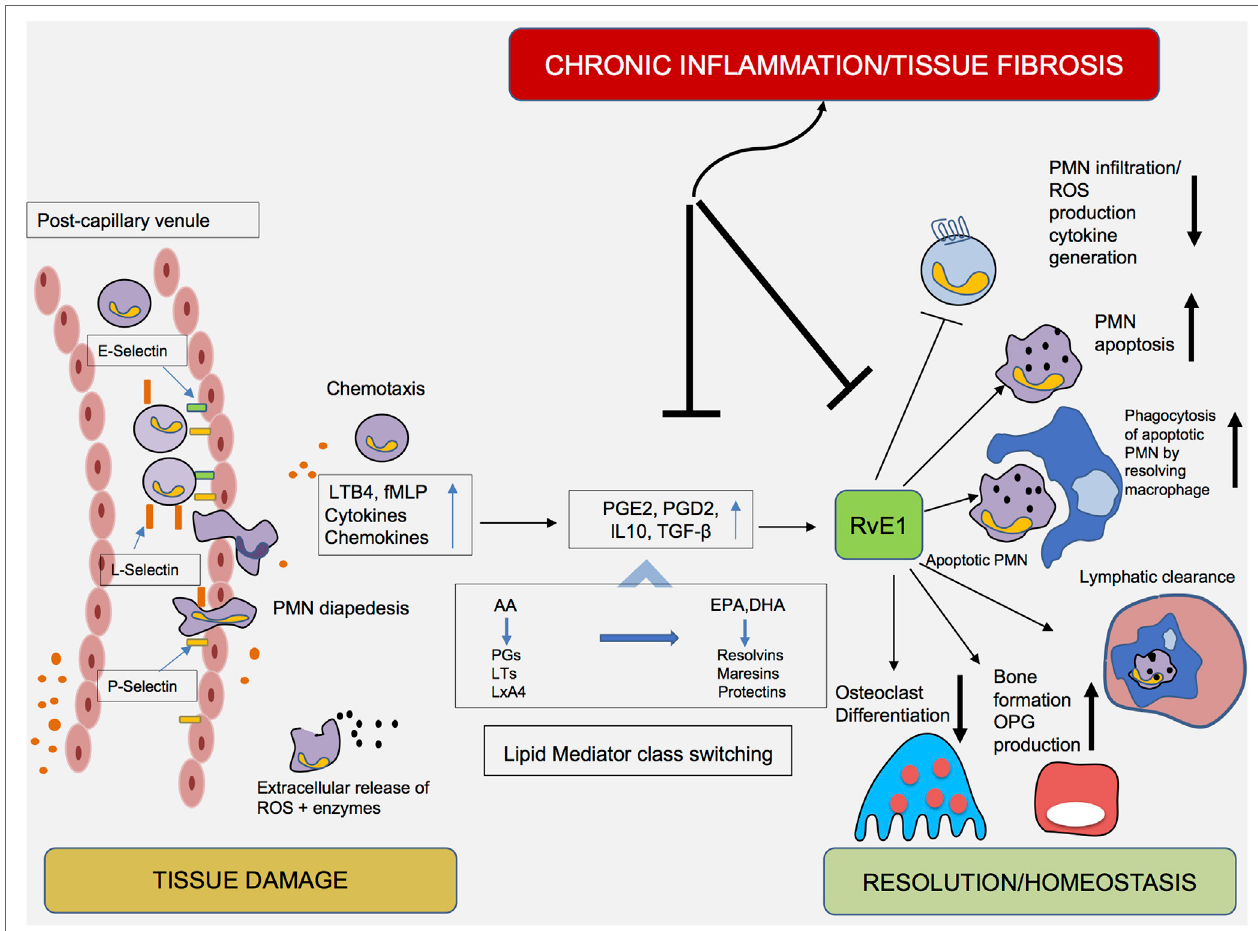
FigURe 2 | Cellular components and mediators of inflammation resolution. An increase in vascular permeability, in combination with the expression of cellular adhesion molecules (i.e., selectins and integrins), enables diapedesis of polymorphonuclear neutrophils (PMNs) to the inflamed periodontal tissue. Under the influence of chemotactic factors, PMNs transmigrate into tissues. The early stages of the inflammatory reaction are characterized by the synthesis of eicosanoids (leukotrienes and prostaglandins), which initiate and amplify PMN chemotaxis. Exposure of PMNs to agents such as PGE2 and PGD2 in the exudate initiate a shift (“lipid mediator class switching”) from proinflammatory eicosanoids toward proresolving lipid mediators, such as Resolvin E1 (RvE1). Acting either as an agonist or antagonist at certain receptors, RvE1 inhibits PMN infiltration and reactive oxygen species production, enhances PMN apoptosis and clearance by “resolving” macrophages and promotes the reduction of PMN influx, a critical prerequisite for the resolution of